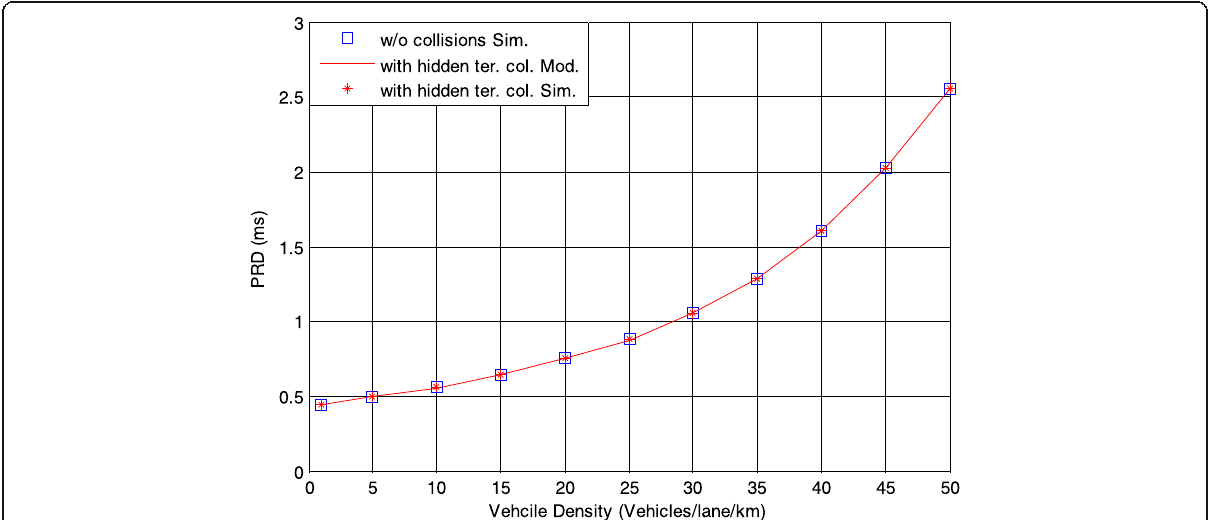
Fig. 17 Comparison of analytical model and simulation results of PRD with the hidden terminal collisions and without collisions with respect to vehicle density, W